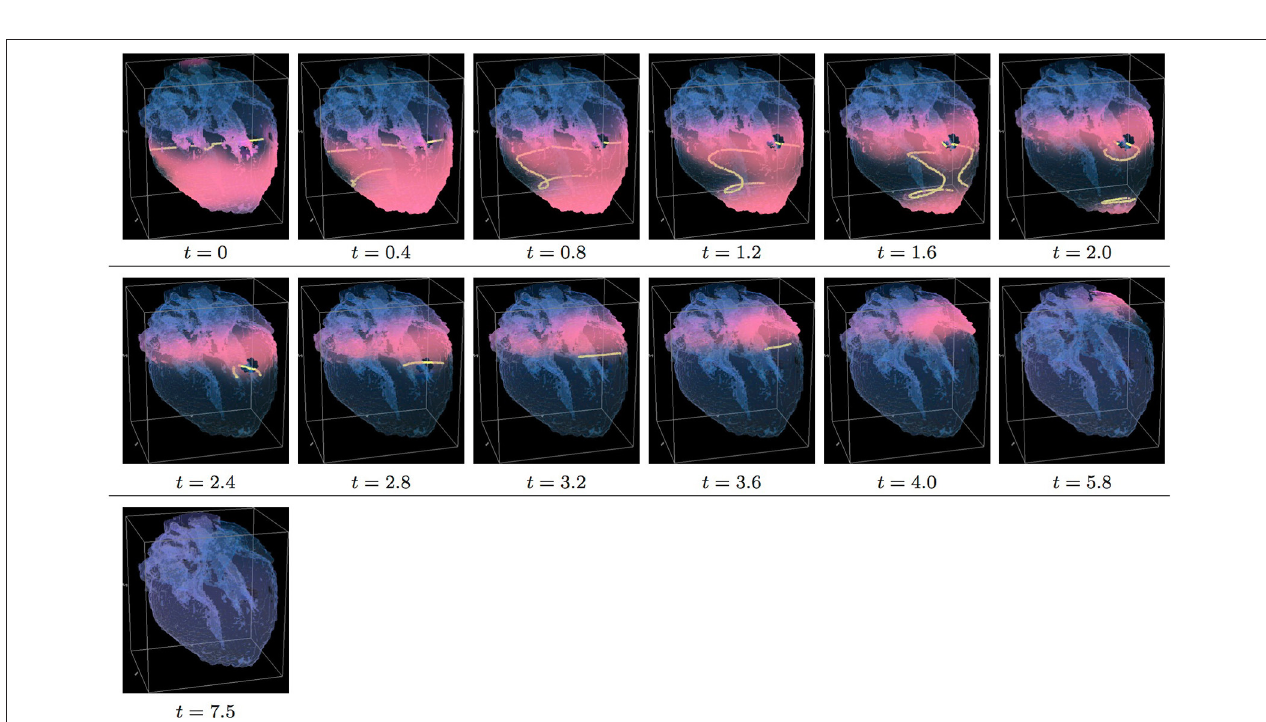
FIGURE 9 | Isotropic “edited” whole heart simulation. The translucent fetal heart is shown in blue, excitation front shown in red (see the color box in Figure 3 ), the yellow lines are the instant organizing filaments of the excitation vortices; time shown under each panel in time units of Equations (1, 2). After a short transient the organizing filament of the initial vortex breaks into the two pieces each of which fast terminates: one at the base and another at the apex of the heart (See Supplementary Video 9